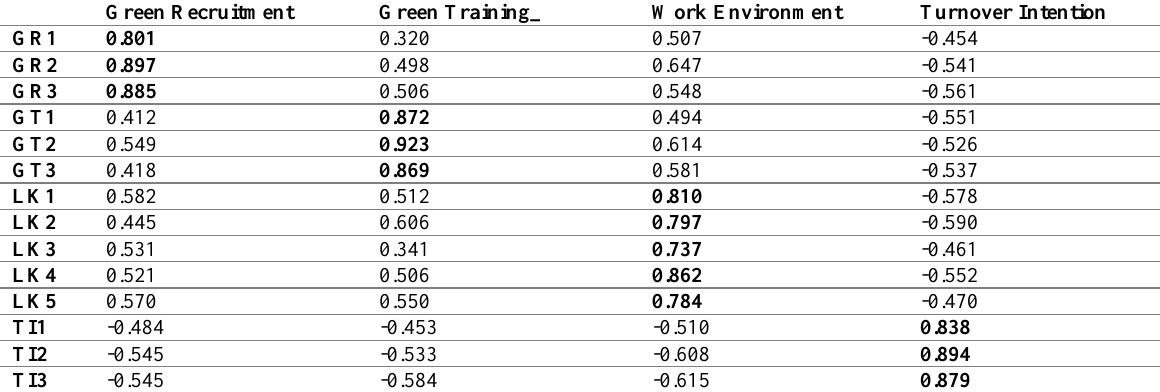
Table 3: Cross Loading Analysis Results / Discriminant Test